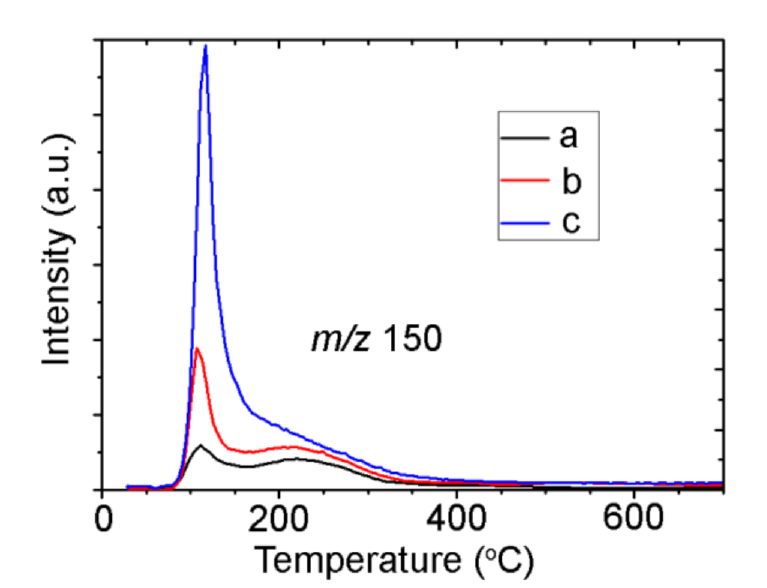
Figure 13. TPD-curves for the ion with m / z 150 (3-methoxy-4-vinilphenol), obtained by thermal decomposition of samples of FA/CeO 2 (a: 0.6 mmol/g, b: 0.9 mmol/g, c: 1.2 mmol/g).